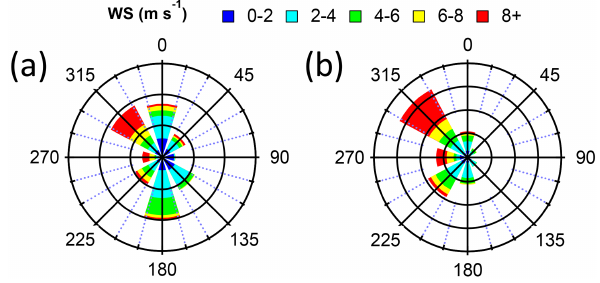
Figure 9. Wind rose plots (a) before APEC and (b) during APEC.